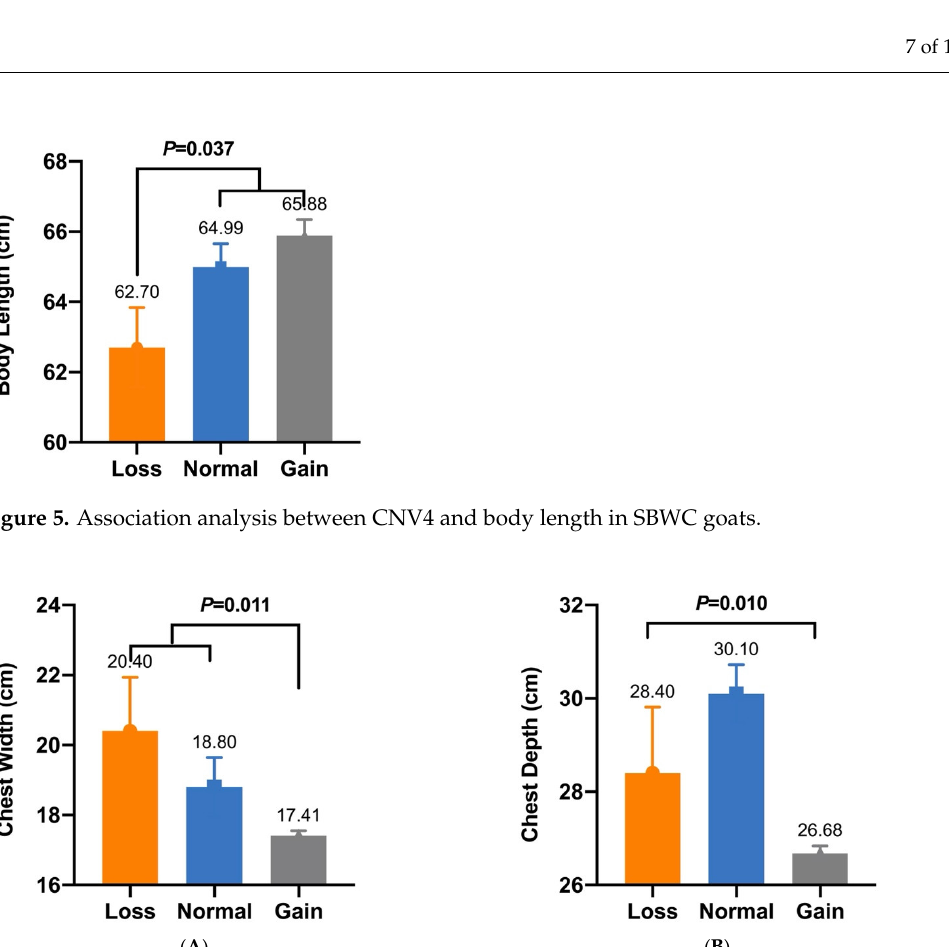
Figure 6. Association analysis between CNV5 and morphometric traits in SBWC goats: ( A ) chest width and ( B ) chest depth. Table 3. Association analyses between morphometric traits and CNVs in Shaanbei white cashmere goats.